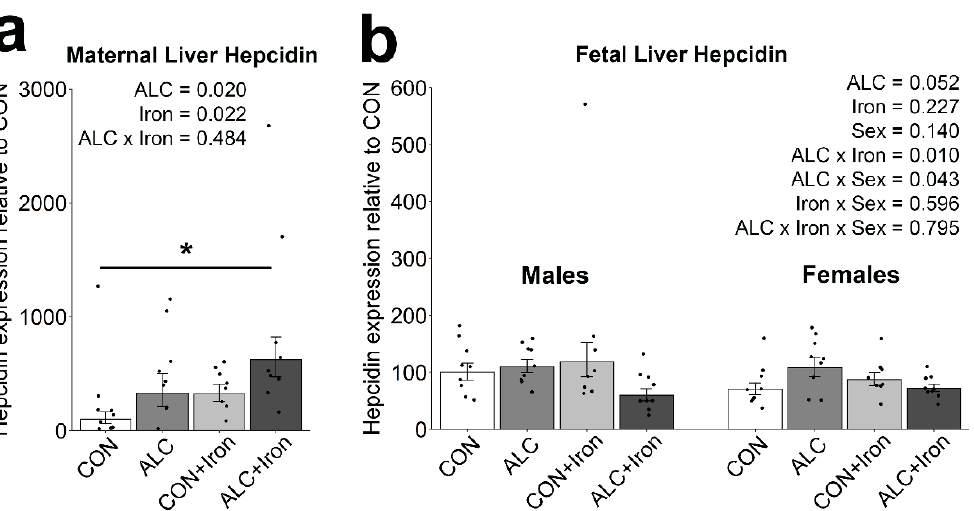
Figure 6. Alcohol exposure and iron induced maternal hepcidin but minimally affected fetal hepcidin. Hepcidin mRNA content was quantified in maternal ( a ) and fetal ( b ) livers at gestational day 20.5. n = 8–9 litters per group, sampling 1 dam, 1 male, and 1 female per litter. Individual points show the values for individual animals, and bars show the group means ± standard error. Maternal data were analyzed using two-way ANOVA and Tukey’s post hoc test, and fetal data were analyzed by mixed linear model and Tukey’s post hoc test. An asterisk denotes a significant difference at * p < 0.05. Abbreviations: ALC, alcohol exposed; CON, control.